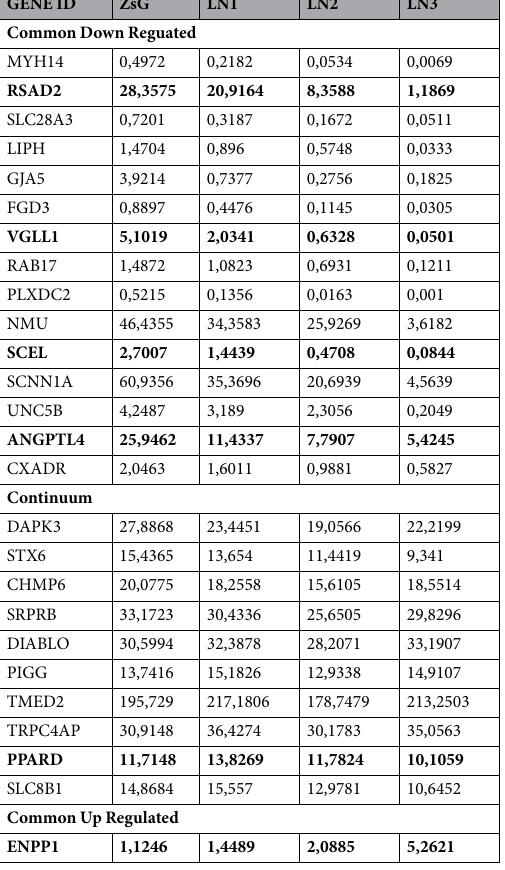
Table 3. Common DEGs displaying altered expression and their regulation into our invasive progression model of tongue cancer and their FPKM expression mean for each cell line. The remarked genes were selected to validate by real time